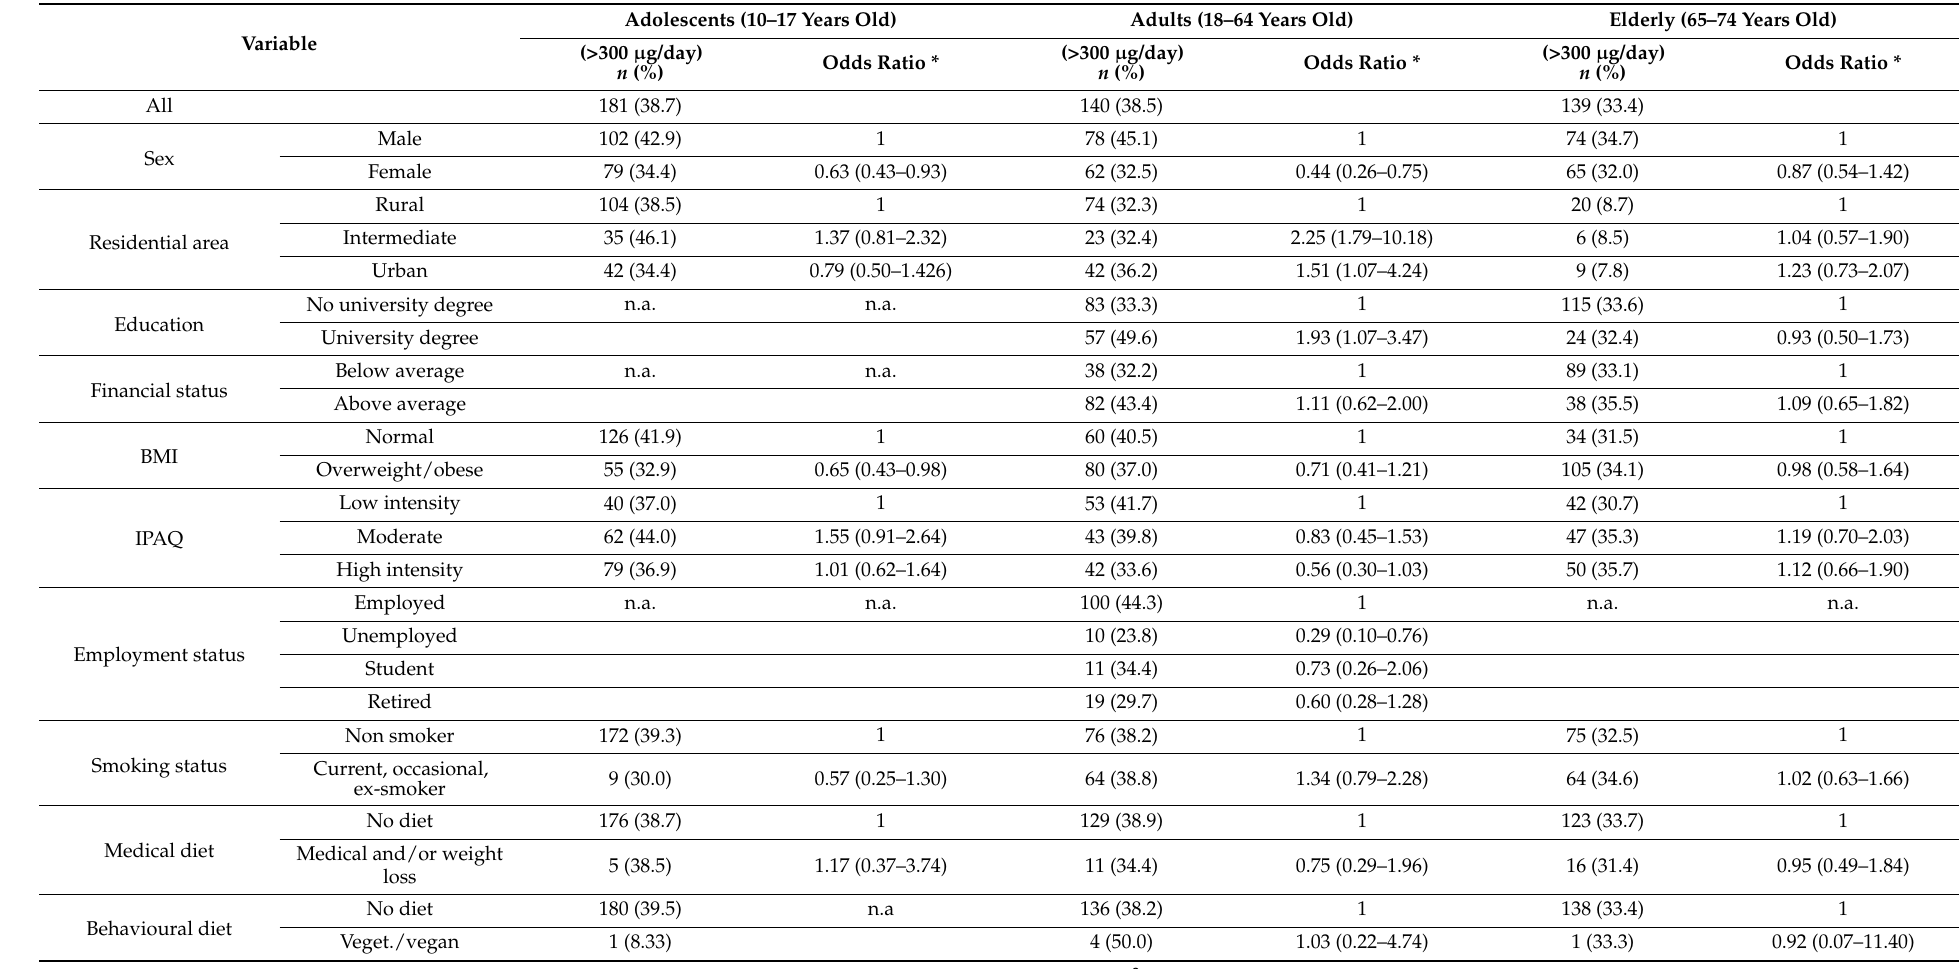
Table 3. Association between daily intake of dietary folate level (>300 µ g/day) and sex, residential area, education, income, employment, smoking status, BMI, IPAQ, dietary